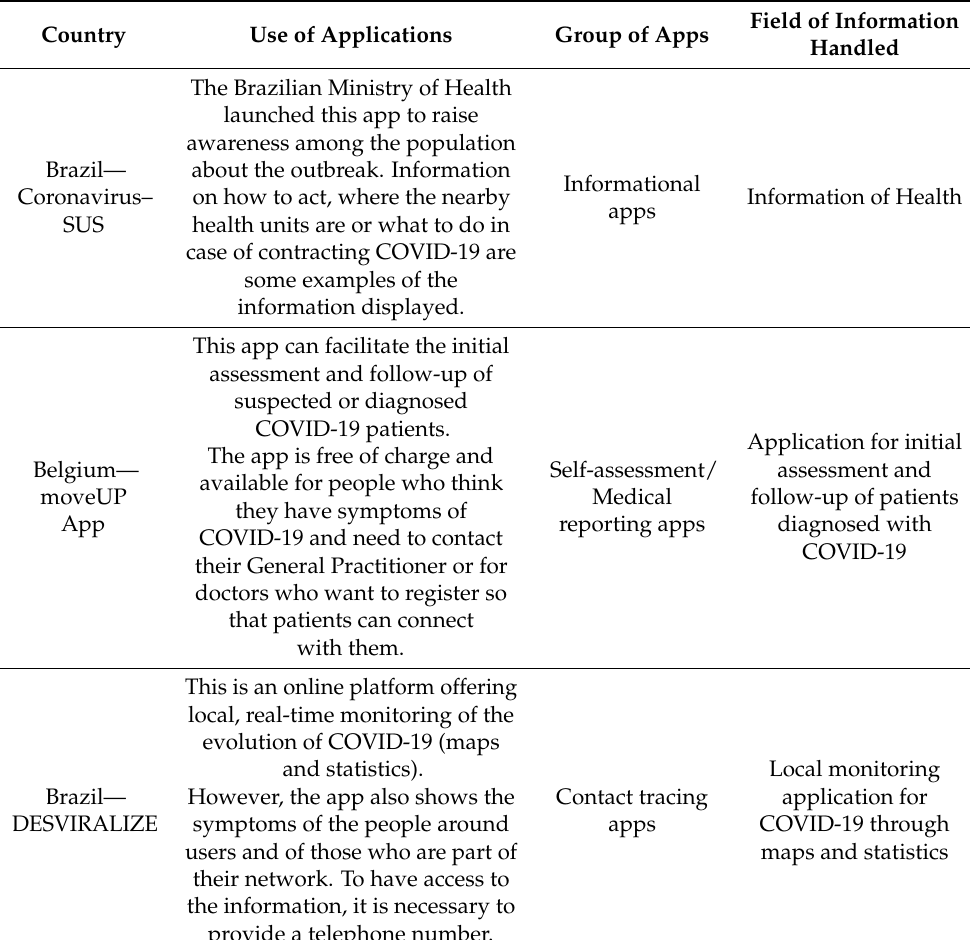
Table 1. Examples of COVID-19 applications in different